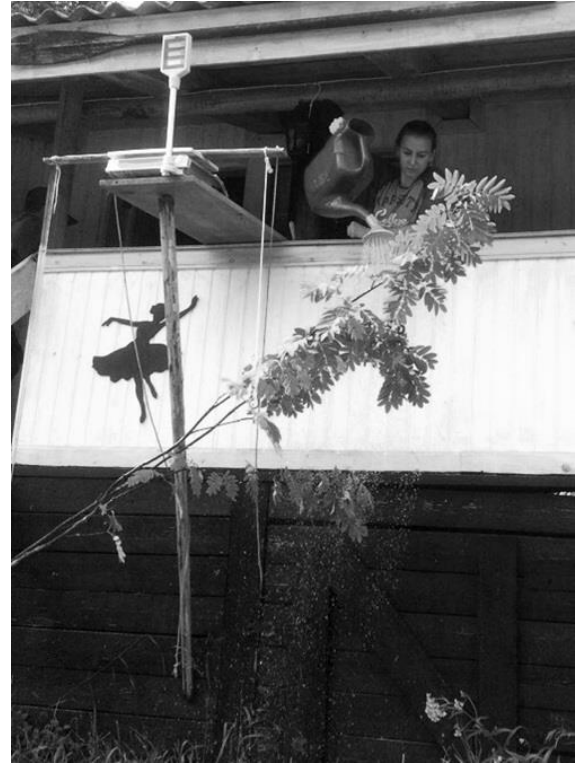
Figure 1. Photograph showing the experimental set up for the artificial sprinkling and weighing of tree branches. Forests 2019 , 10 , x FOR PEER REVIEW